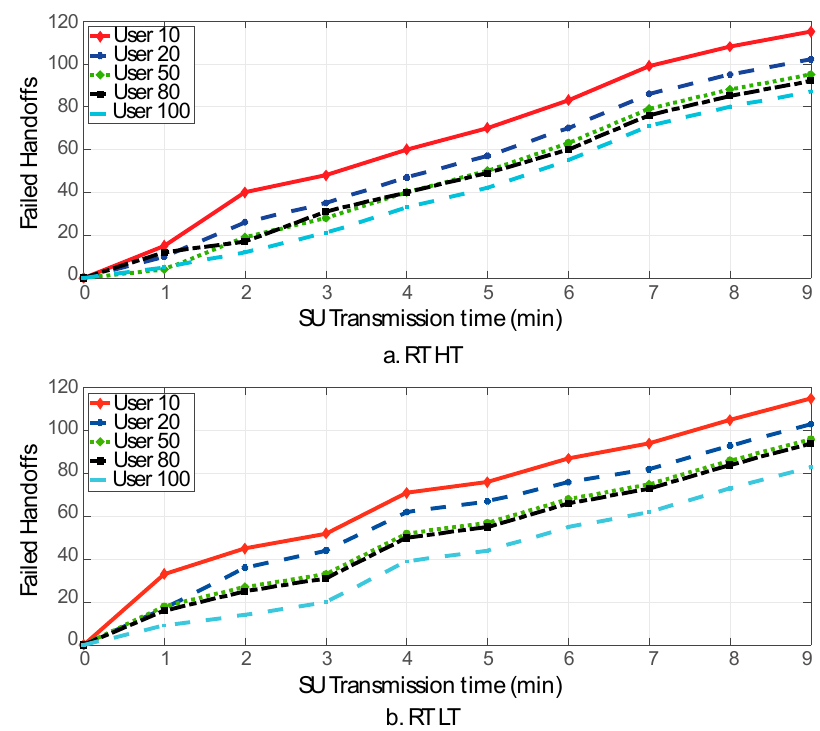
Figure 15. Failed handoffs for FFAHP: ( a ) Real time (RT) and high traffic (HT); ( b ) Real time (RT) and low traffic (LT).